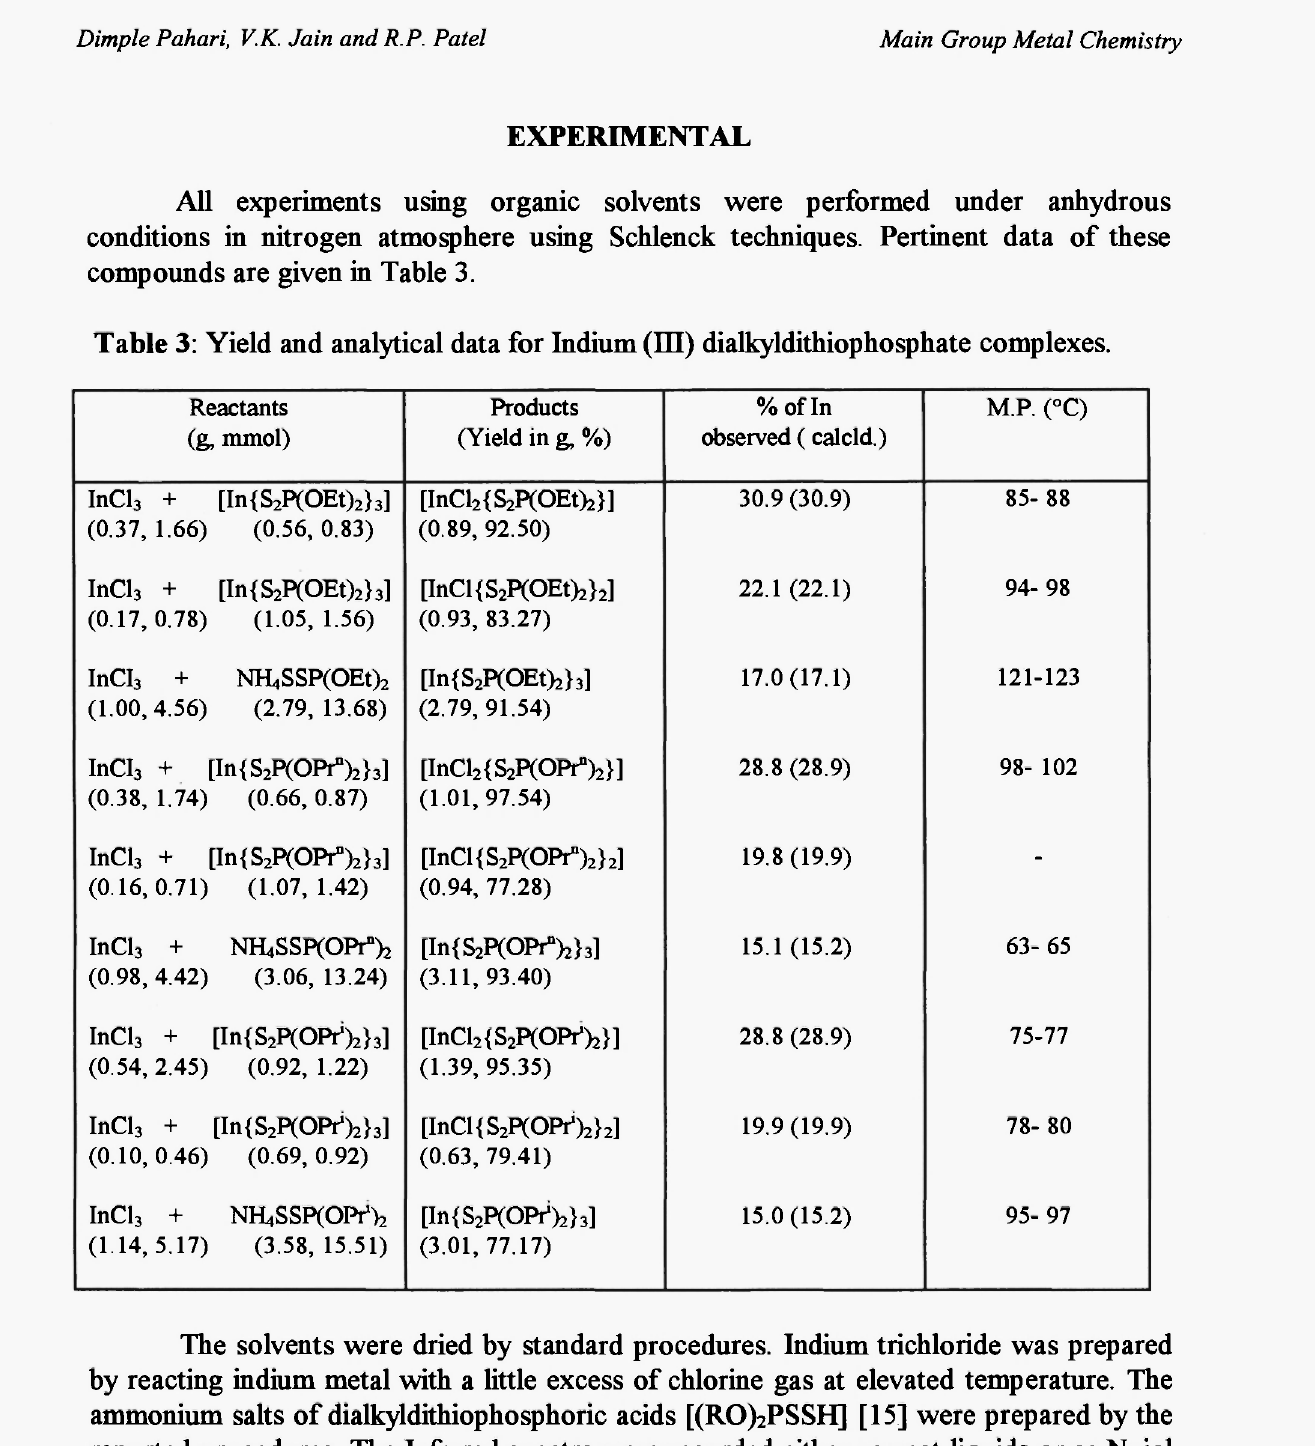
Table 3: Yield and analytical data for Indium (ΙΠ) dialkyldithiophosphate